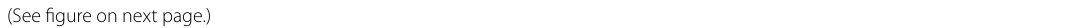
respectively(See figure on next Fig. 7 Image of the estimated rotation axes and observed target positions for the outside method. a Az axis and target positions. Red-colored vertical line stands for the estimated Az axis. Red dots represent the observed target positions. Red-colored circles represent the trajectory of the target positions used for the estimate of Az axis; b El axes and target positions. Colored horizontal lines stand for the estimated El axes. Colored dots and circles represent the observed target positions and trajectory of the target positions,